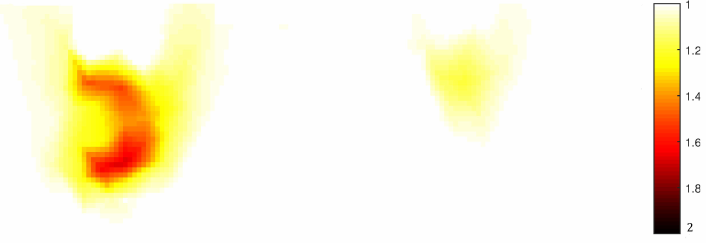
Figure 5. Spatial distribution of shoaling coefficient obtained with scheme